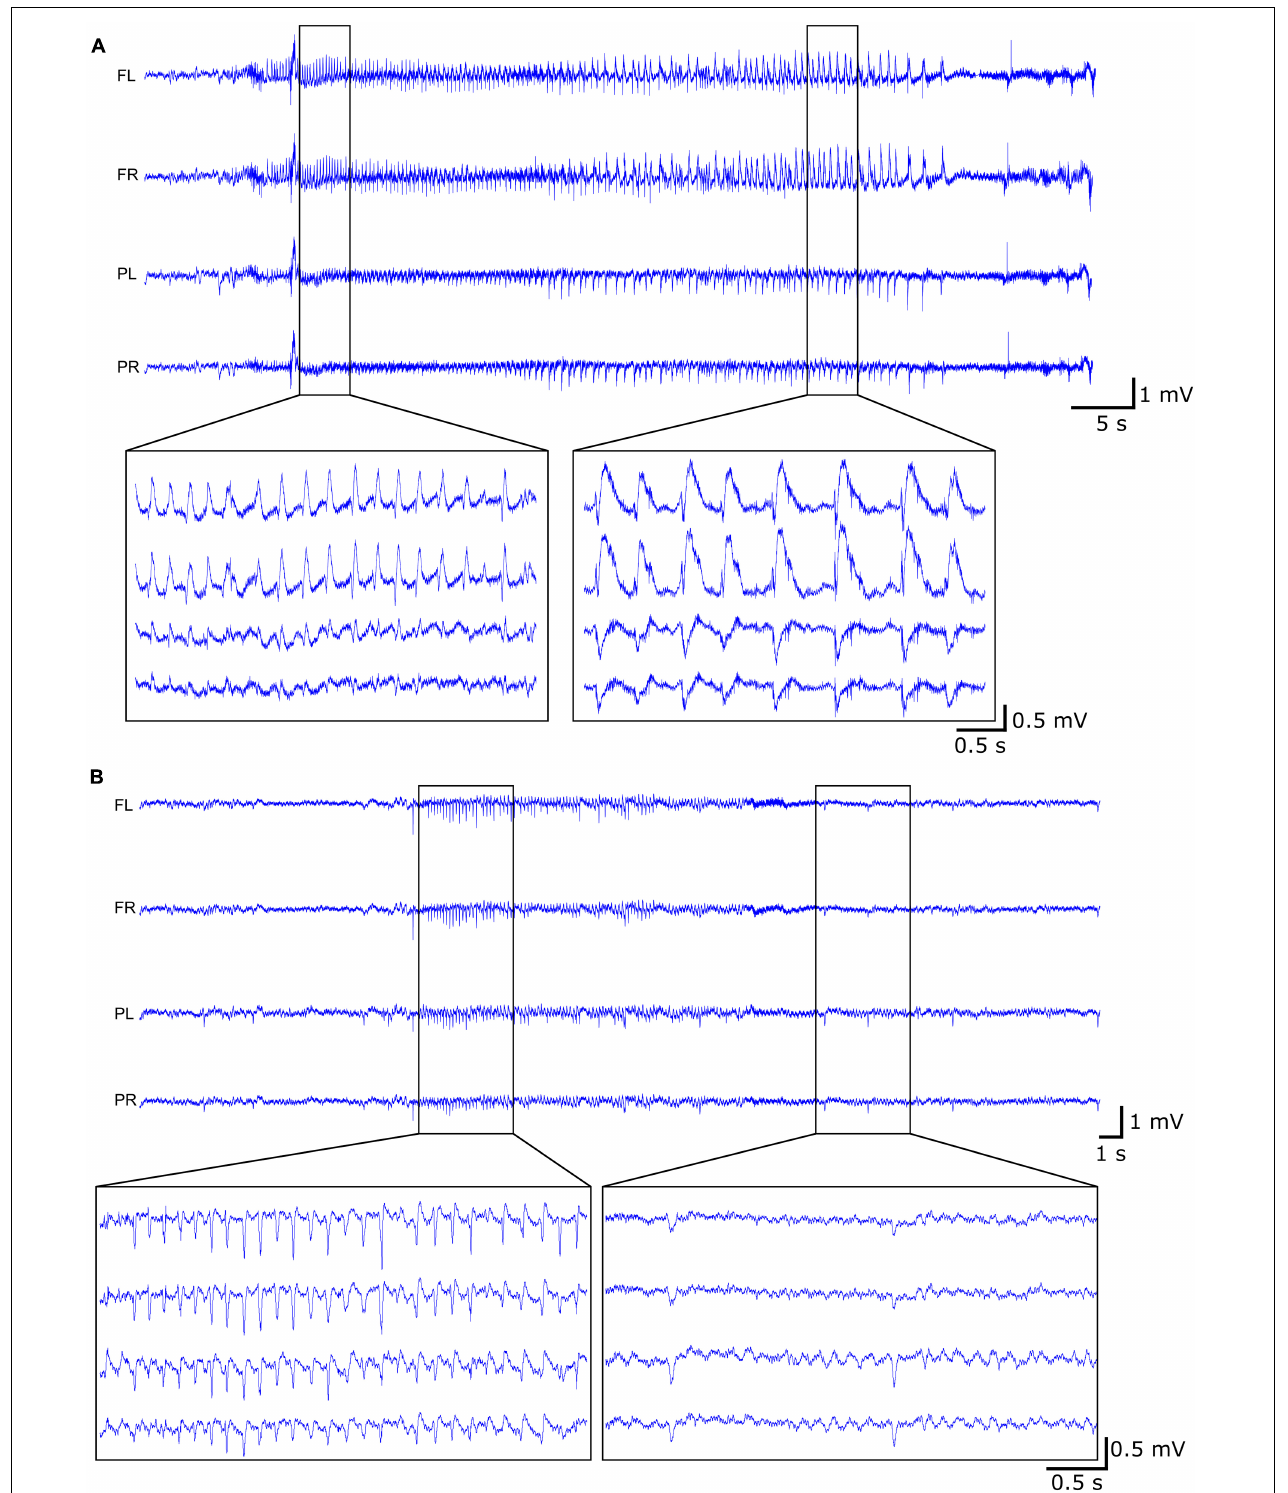
FIGURE 2 | Example of EEG trace during (A) late seizure (rat 10) and (B) interictal activity (rat 08) with both the epileptiform discharges (left) and the interictal spikes (right).